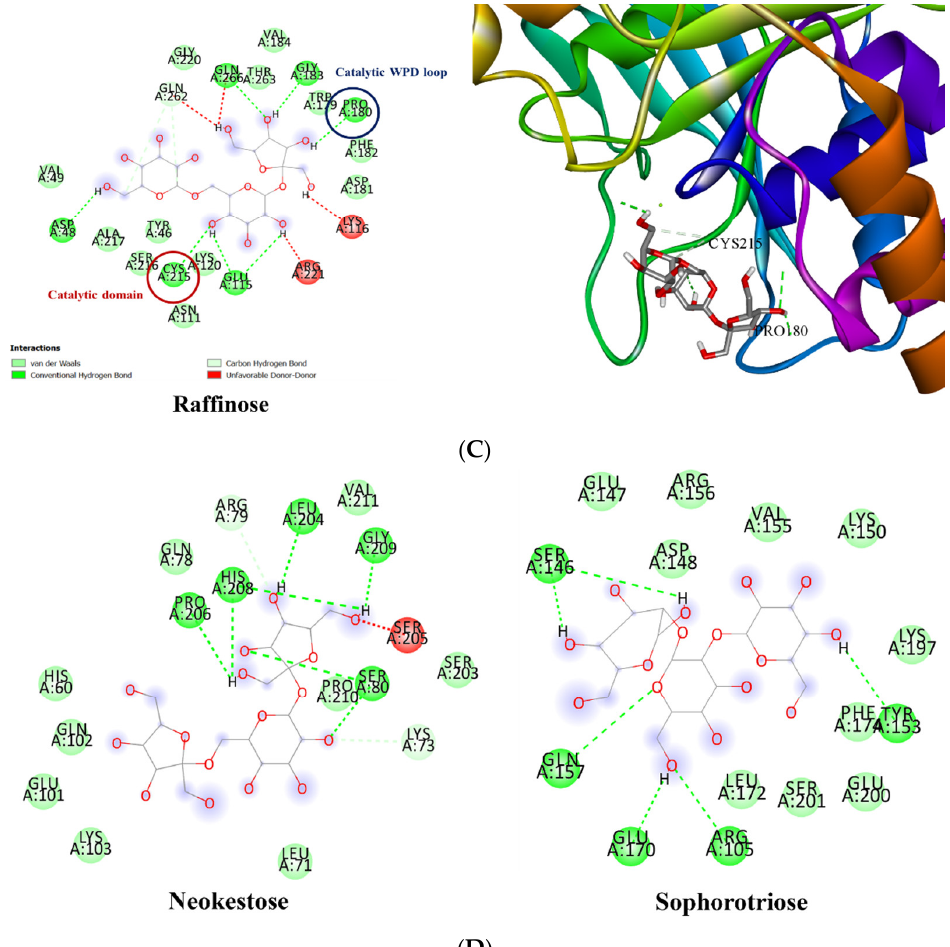
Figure 5. The crystallographic structure of PTP1B molecular docking related five oligosaccharides. Hydrogen bond of gentiobiose binding to the catalytic active sites of PTP1B Pro180, Cys215, and Ala217 residue of the catalytic WPD loop, catalytic domain, and catalytic loop, respectively ( A ). Melibiose showed ligand binding to Cys215 of the catalytic domain and Arg221 of the catalytic loop ( B ). Pro180 and Cys215 of the catalytic WPD loop and catalytic domain were bound to raffinose with hydrogen bonding ( C ). Neokestose and sophorotriose were not bound to any of the active residues ( D ).